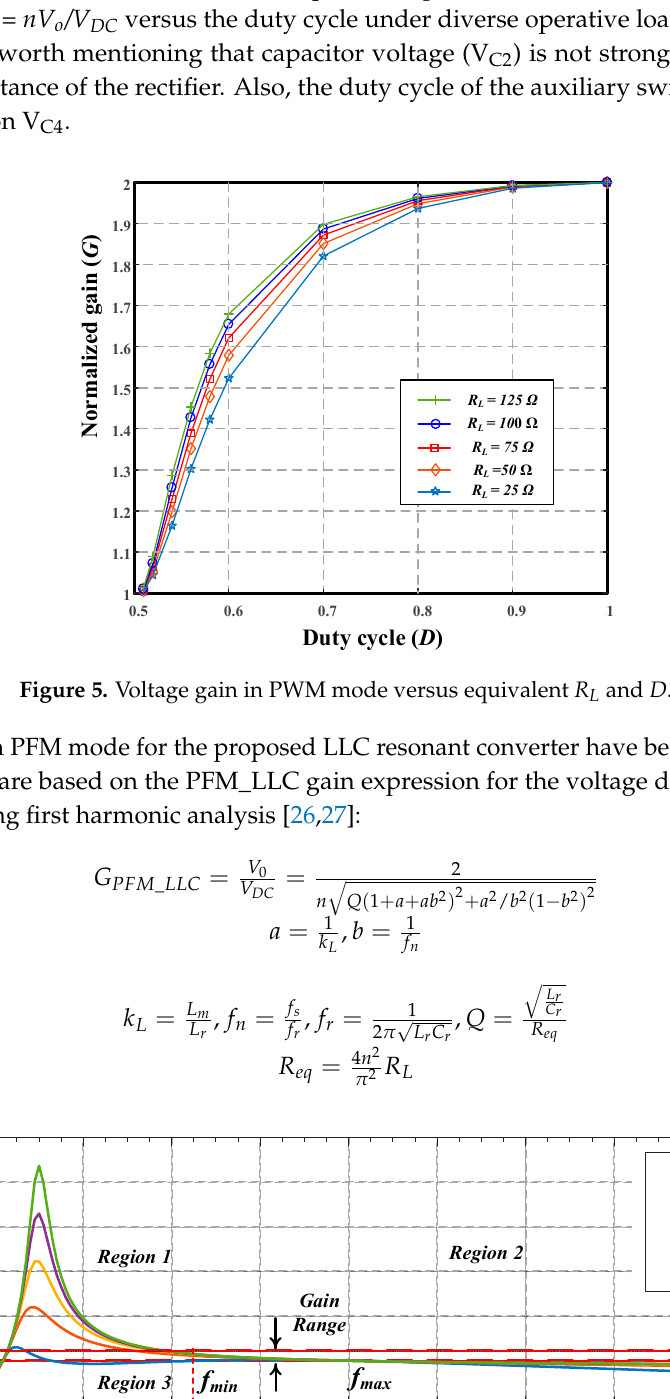
Figure 6. Gain curves of the proposed converter under pulse frequency modulation (PFM) in FM.